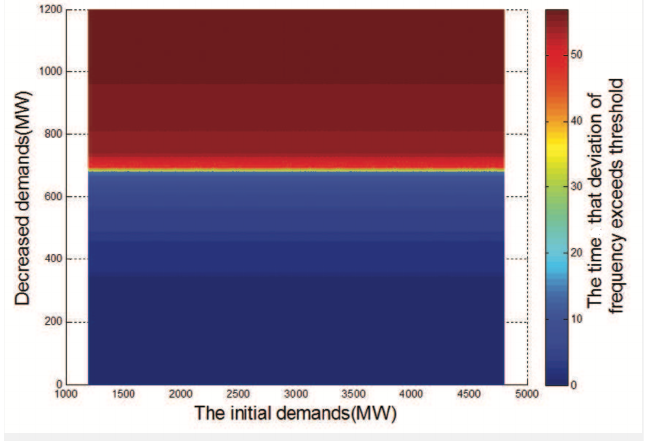
Figure 15. The relationship among initial demands, changed demands, and the attack